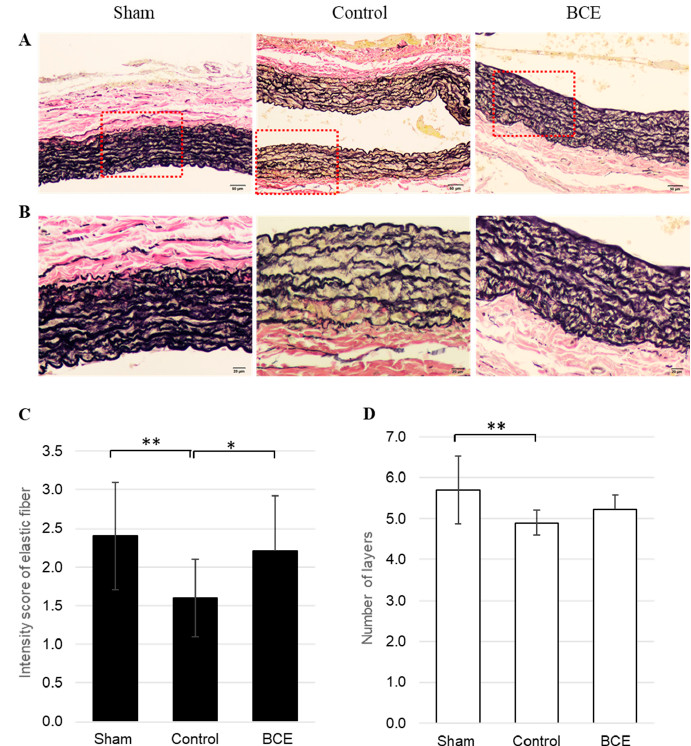
Figure 1. Representative images and semi-quantification of elastic fibers in Elastica van Gieson- stained tissues. ( A ) 100x magnification (scale bar = 50 μ m) and ( B ) 200× magnification (scale bar =